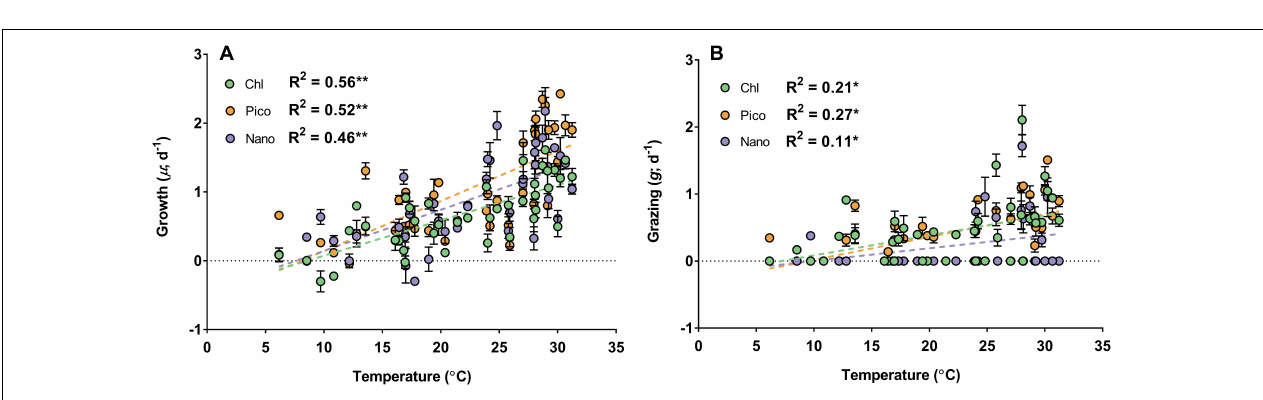
FIGURE 4 | Ratio of instantaneous phytoplankton growth versus nutrient-amended growth rates ( µ / µ n) measured each week for chlorophyll (green), picoeukaryotes (orange), and nanoeukaryotes (purple). Seasons are below x -axis. Red line indicates 1:1 growth ratio, with smaller values indicating enhanced phytoplankton nutrient limitation. Error bars represent one standard deviation of the mean. Ratios > 2 or –2 were measured once for picoeukaryotes (12/18) and twice for nanoeukaryotes (1/18, 3/22) and were excluded (see Supplementary Tables 4 , 5 ).